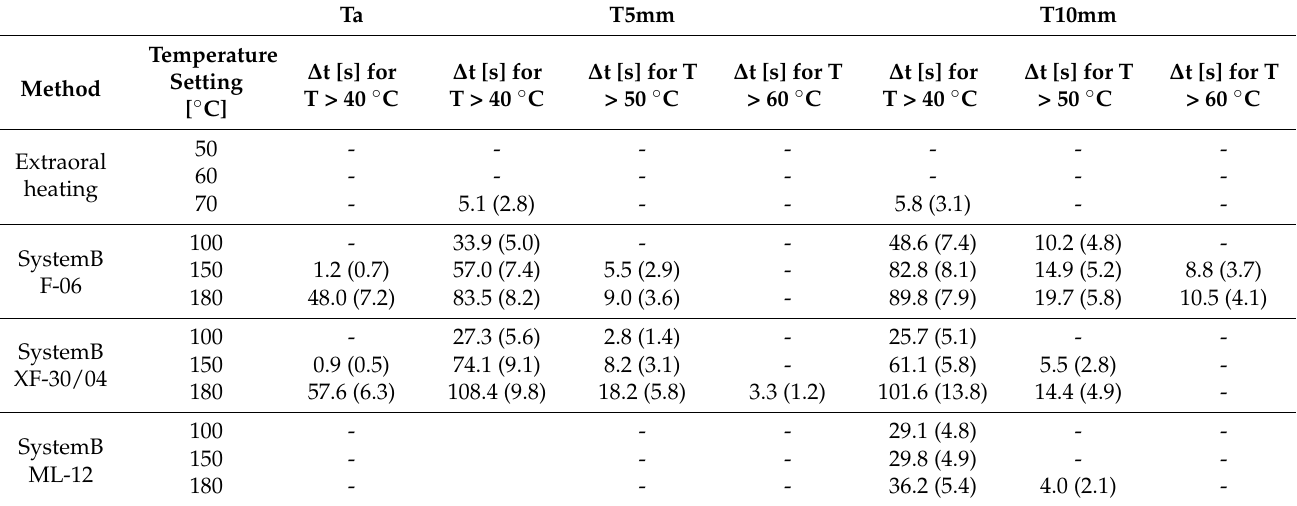
Table 1. Time interval (seconds) in which temperature at the apical and middle third regions